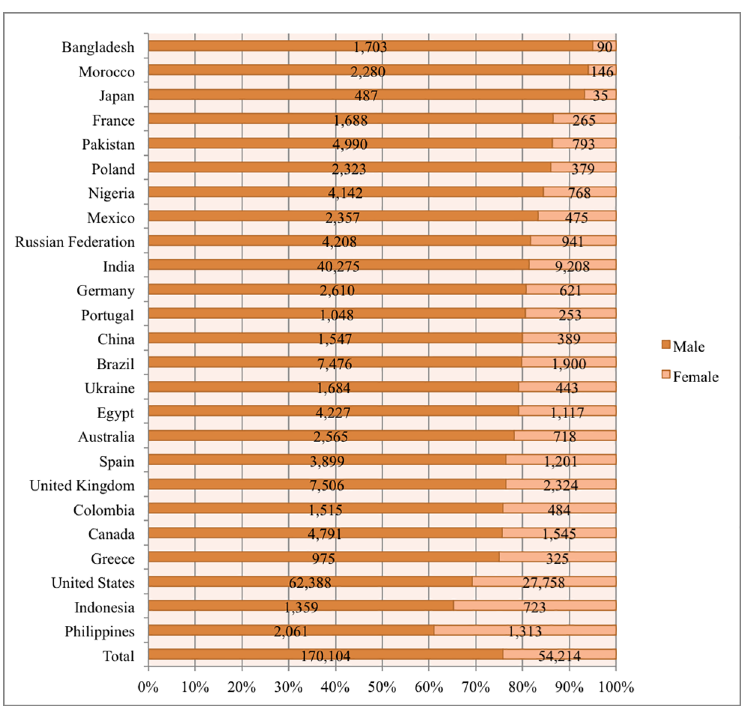
Fig 1. Number of males and females who enrolled in one or more STEM MOOCs in each country.